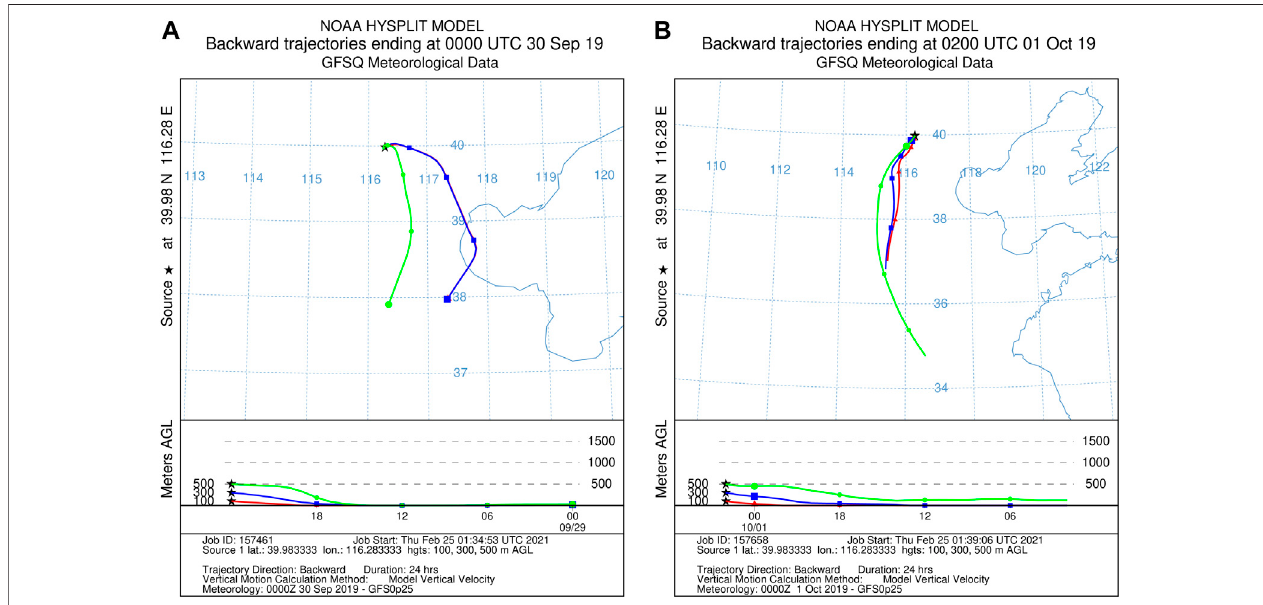
FIGURE13|(A) Backwardtrajectoriesofaerosolsatthealtitudesof100,300,and500 mat8:00on30September2019,Beijingtime. (B) Backwardtrajectoriesof aerosols at the altitudes of 100, 300, and 500 m at 10:00 on 1 October 2019, Beijing